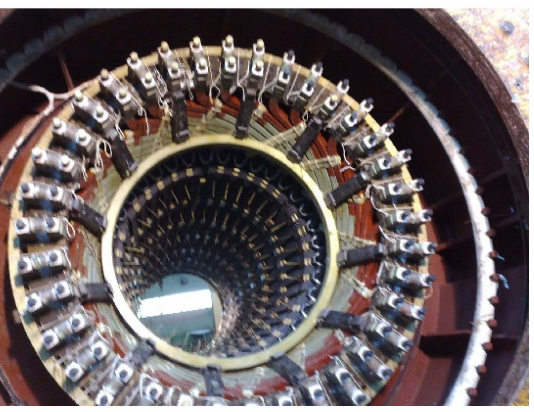
Figure 1. End structure of hydrogen-cooled turbo-generator